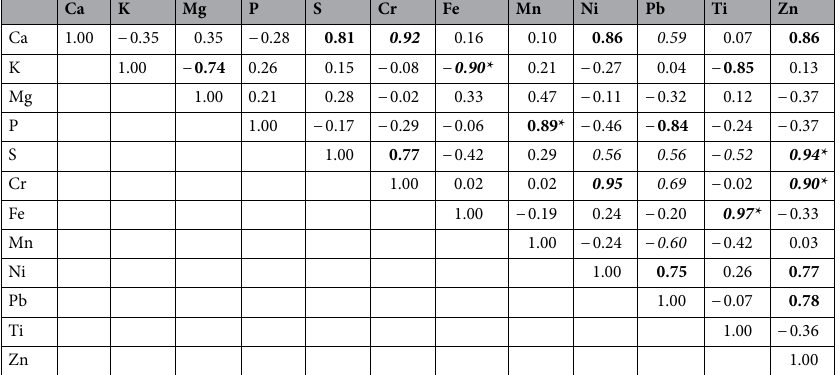
Table 2. Correlation coefficients (r x,y ) between the elements’ contents in lettuces growing on unfertilized soil from industry area. 0.5 ≤ r < 0.7 high correlation (italics); 0.7 ≤ r < 0.9 very high correlation (bolded); 0.9 ≤ r < 1.0 almost full correlation (bold italics); * p < 0.05 statistically significant (emphasis).